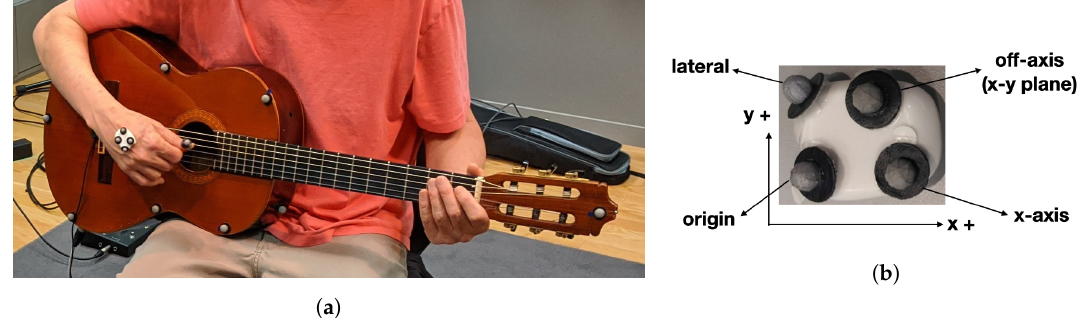
Figure 4. Guitar and IMU used in this study which were set as rigid bodies in the Qualisys motion capture system. ( a ) Guitar with markers; ( b ) IMU with